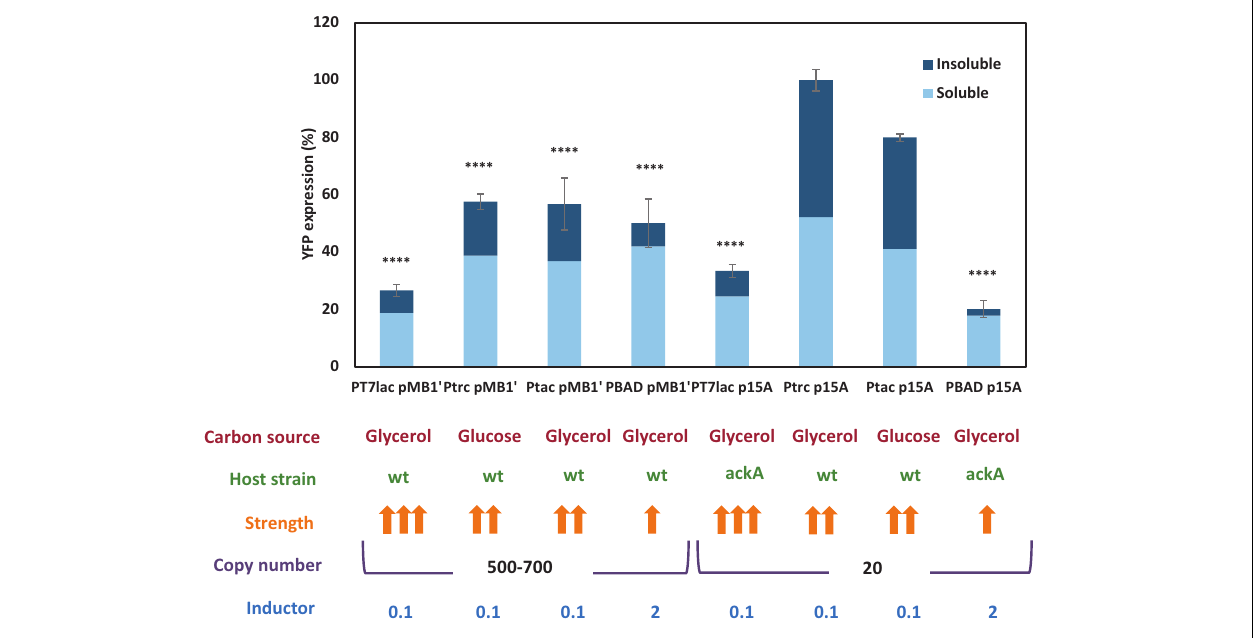
FIGURE 5 | Soluble and insoluble percentage of YFP measured for each expression vector. The fluorescence is indicated as a percentage, with 100% as observed with the pSF-p15A-trc-YFP vector. Carbon source, host strain, strength of the promoter, inductor concentration, and vector copies are shown under the graph. Statistical analysis by one way ANOVA was carried out with Graphpad Prism 7.0 [ p value < 0.0001 ( ∗∗∗∗ ), < 0.001 ( ∗∗∗ ), < 0.01 ( ∗∗ ), and < 0.05( ∗